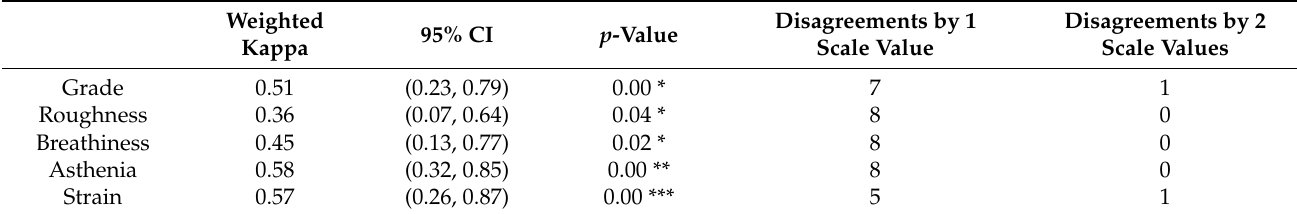
Table 2. Interrater agreement for GRBAS scale. Kappa interrater agreement between two listeners in the first listening session across 21 participants.